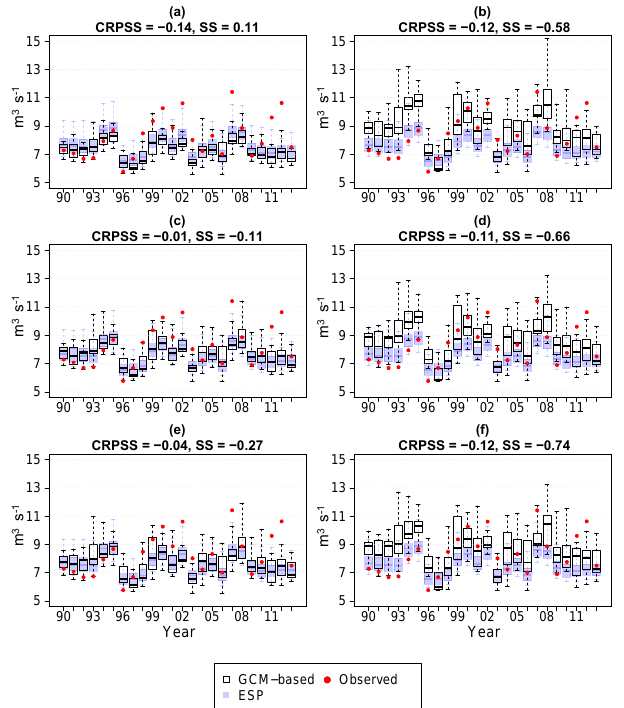
Figure 11. Forecasts of minimum daily flows for each year of the period 1990–2013, considering a forecast issued on 1 April for the next 7 months. Forecasts are generated using raw forcings (a) , pre- processed forcings with the linear scaling/delta change (c) and the quantile mapping (e) methods and post-processed streamflow for forecasts generated using raw (b) and preprocessed inputs ( d and f ). Blue shaded box plots are ESP forecasts. CRPSS and SS are com- puted using Eq. (4) with ESP as